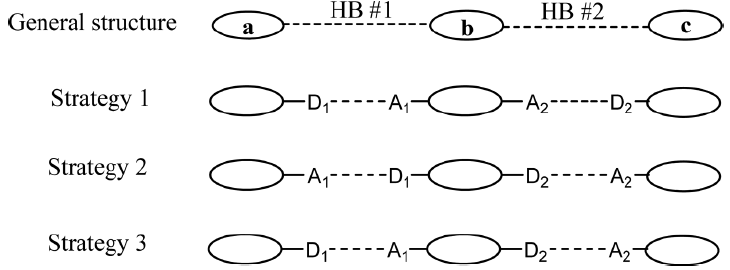
Figure 24. Schematic representation of possible structures of hydrogen-bonding interactions in ternary cocrystals [HB # 1 and HB # 2 -Hydrogen bonds 1 and 2; A 1 ,A 2 -Hydrogen bond acceptors and D 1 ,D 2 -Hydrogen bond donors] [Reprinted from [264] with permission. Copyright 2016 American Chemical Society].